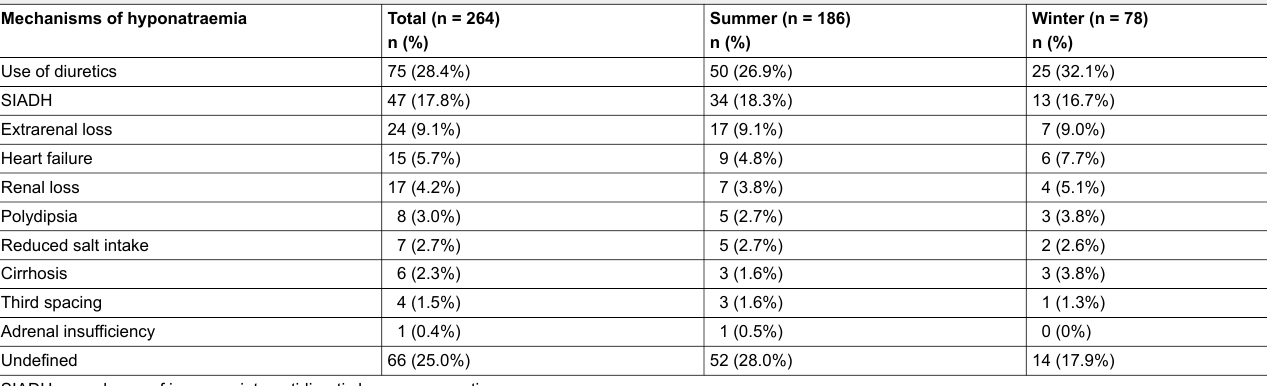
Table 1: Mechanisms of profound hyponatremia during summer and winter periods. Mechanisms of